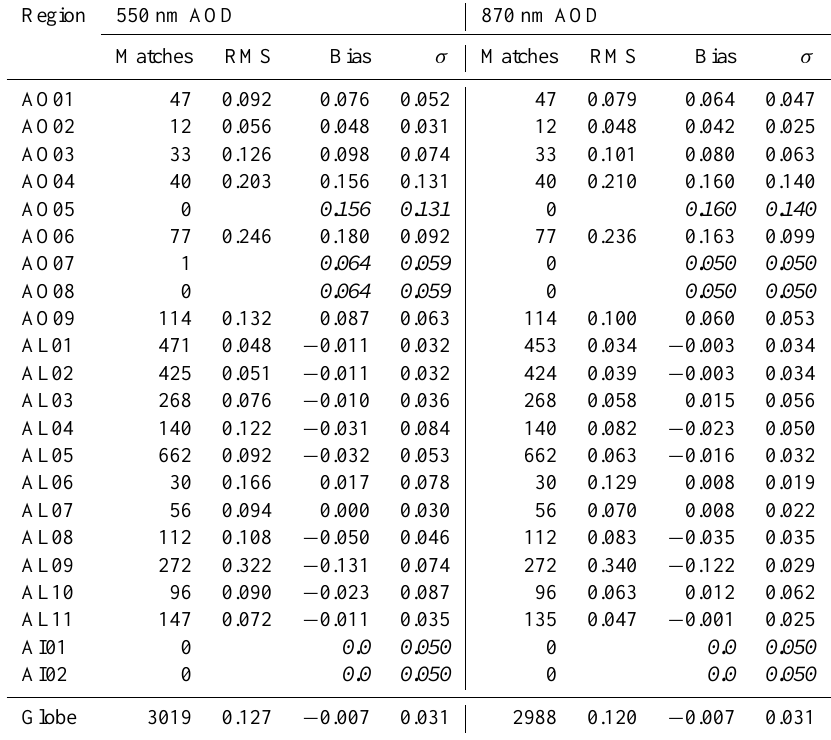
Table 1. Regional error analysis of the GlobAEROSOL-AATSR AOD dataset against AERONET. Values for the number of acceptable matches, root-mean-squared difference (RMS) of retrieved AOD, average bias (GlobAEROSOL-AERONET) and standard deviation of the bias ( σ ) are given. Italic values indicate those estimated from similar regions or the global comparison due to a lack of AERONET- GlobAEROSOL matches. Note that differences between the number of matchups at 550 and 870nm are due to AERONET not always providing AOD measurements at all